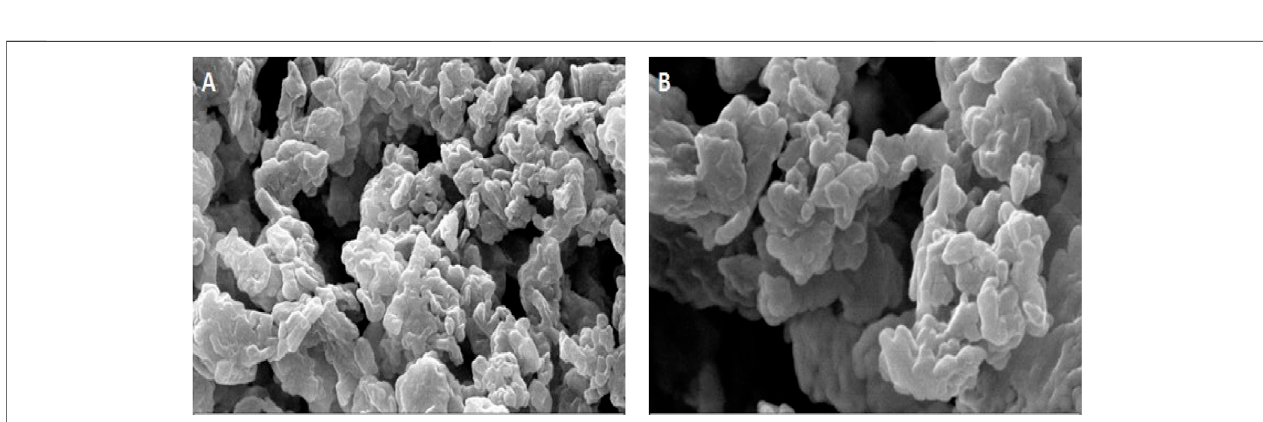
FIGURE 2 | SEM electron microscope image of